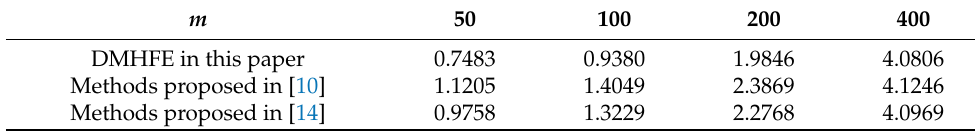
Table 3. Run time (s) under different simulation times m